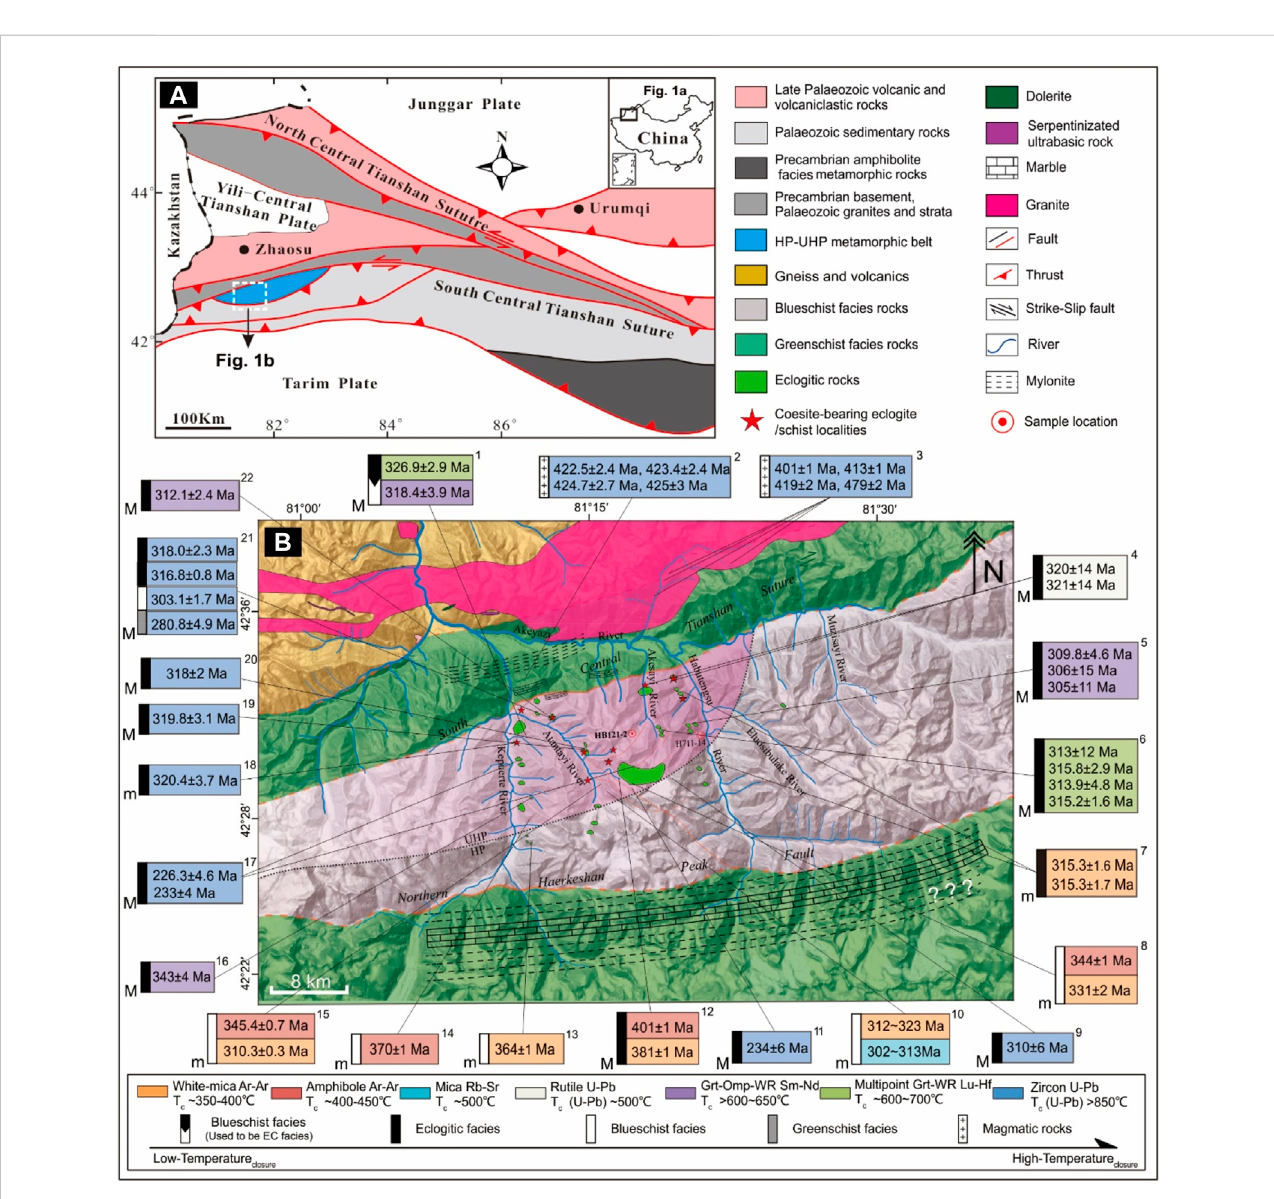
FIGURE 1 (A) Geological sketch map oftheWesternTianshan orogenicbeltinNW China. (B) Geological mapof theHabutengsu – KebuerteHP-UHP metamorphic belt with tagged localities of published geochronological data (detailed information in Zhang et al.,